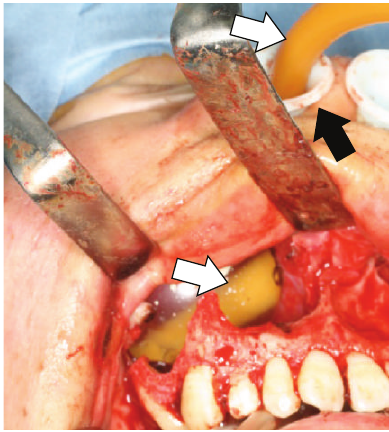
Figure 1: A preoperative coronal computed tomography scan shows a large cystic lesion involving the right maxillary sinus and inferior nasal meatus.